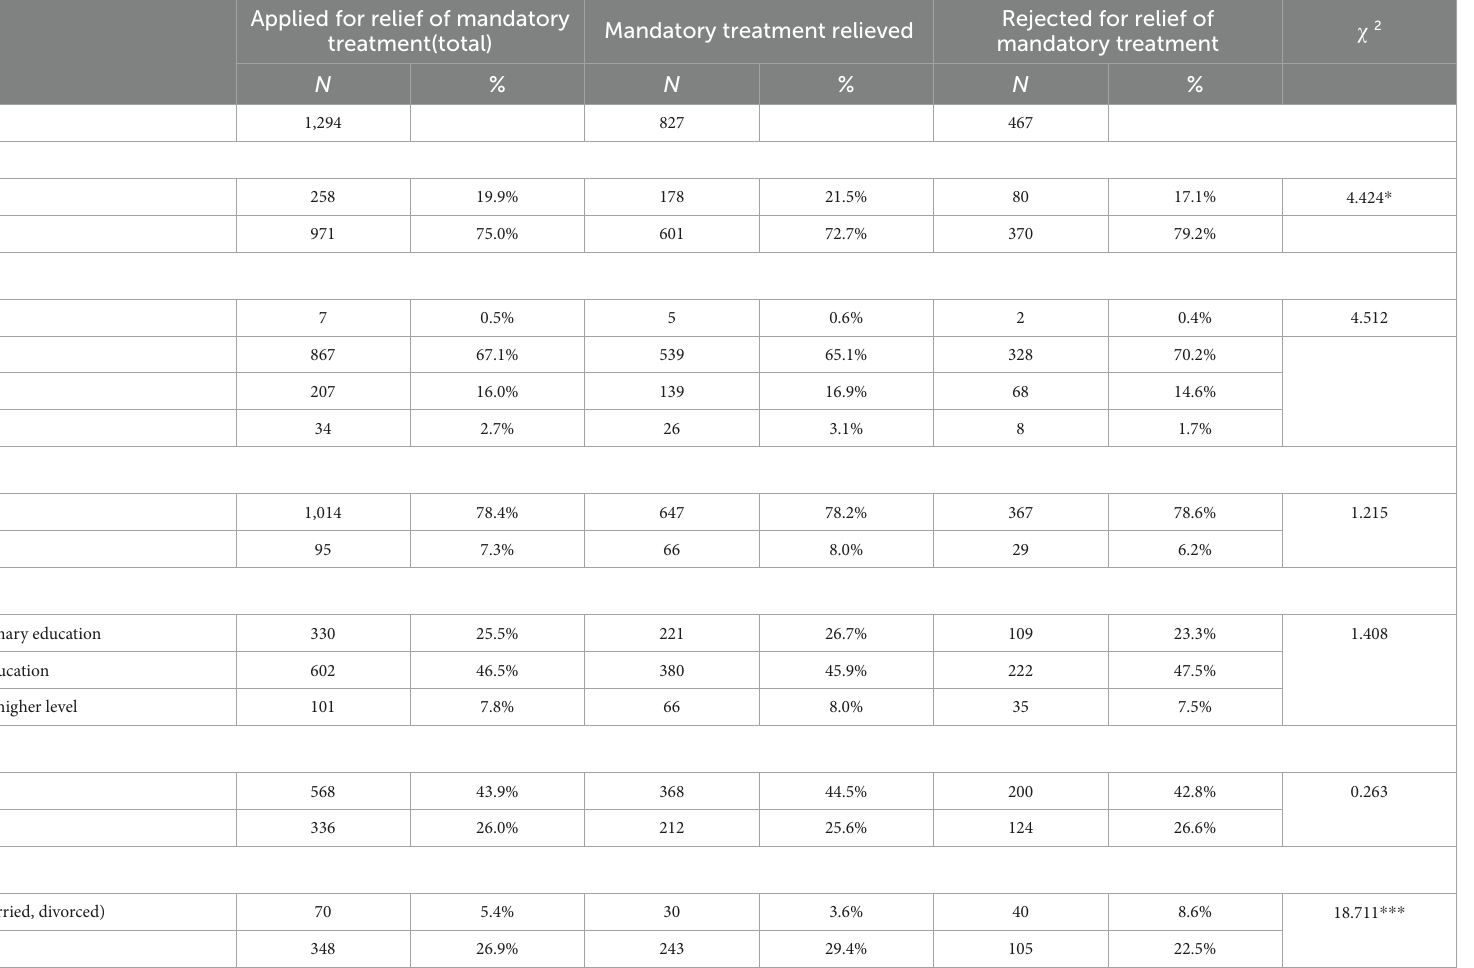
Applied for relief of mandatory Mandatory treatment relieved treatment(total)